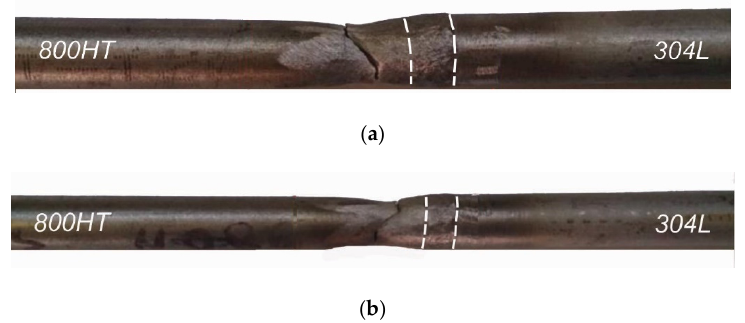
Figure 4. Specimens after transverse tensile test ( a ) specimen A; ( b ) specimen B. Dashed lines mark welds. Table 5. Tensile test results of welded joints.